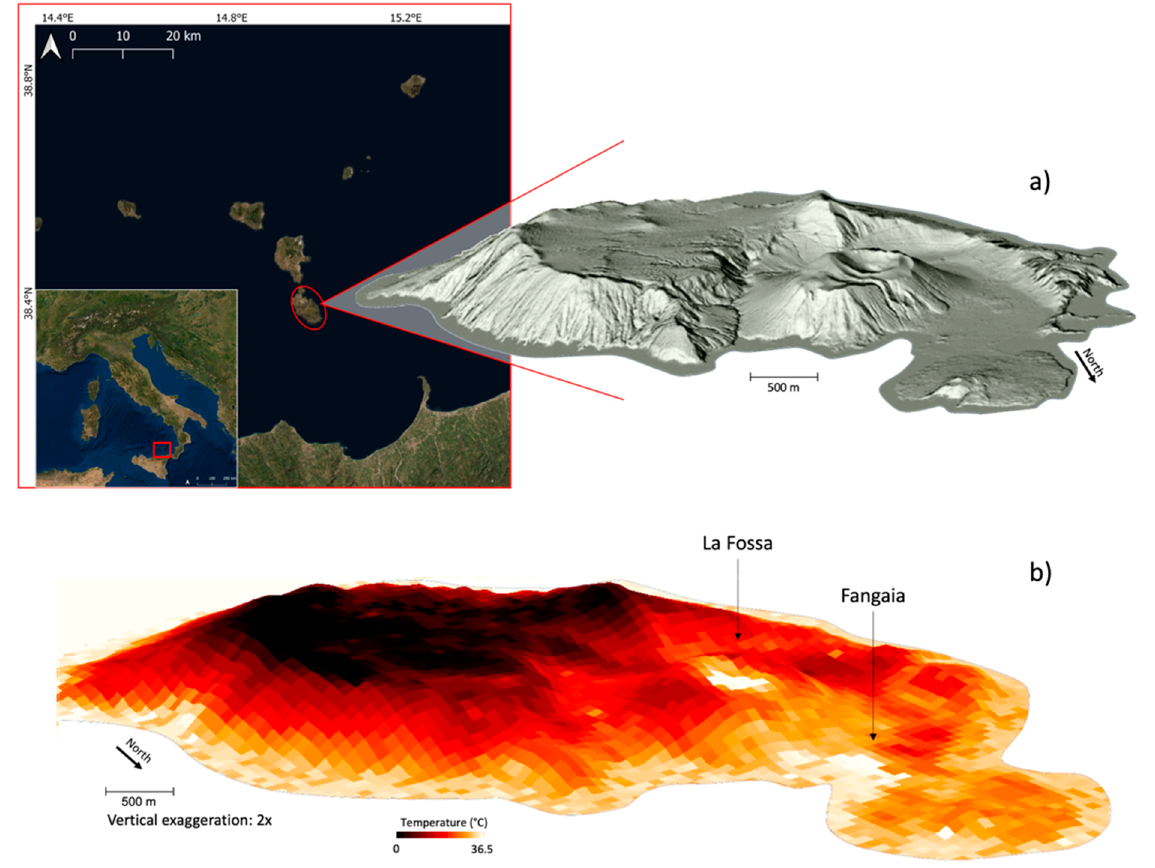
Figure 1. Location and 3D model of Vulcano Island ( a ); 3D view of Land Surface Temperature maps with two detectable thermal anomalies: “ La Fossa ” and “ Fangaia ” ( b ).